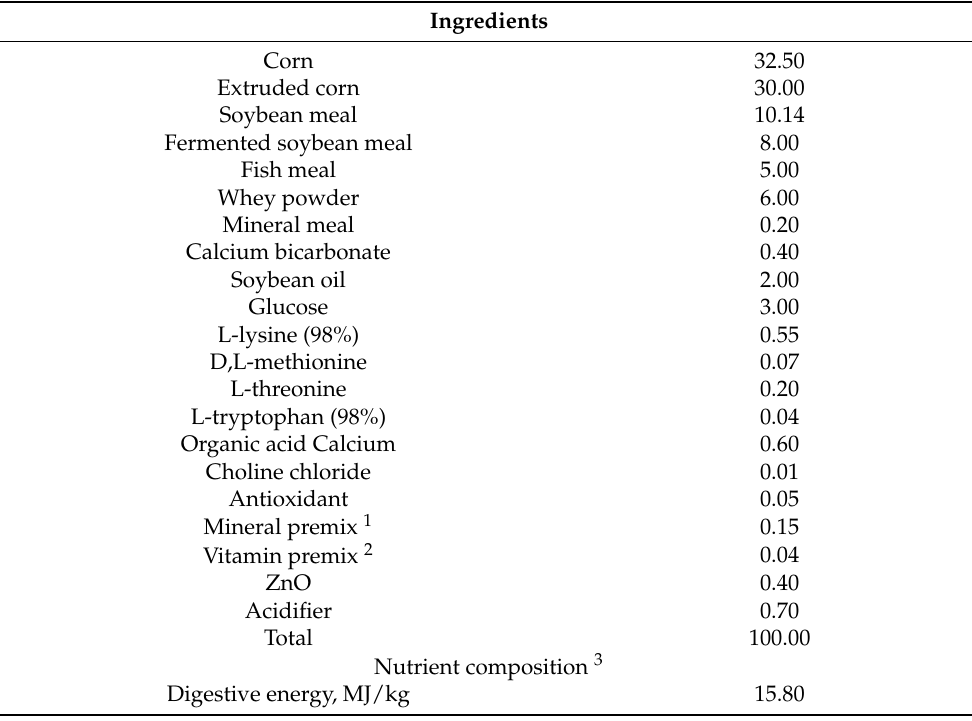
Figure 1. Ellagic acid supplementations alleviated the oxidative stress and growth-check of piglets challenged by paraquet. ( A ) Study design. ( B ) The BW changes of piglets on d-18 and d-21 of experiment (before and after PQ injection). ( C – E ) Superoxide dismutase (SOD), catalase (CAT) activities, and malondialdehyde (MDA) levels in serum of piglets. PQ = 4 mg/kg paraquet; EL = 0.005% ellagic acid + 4 mg/kg paraquet; EM = 0.01% ellagic acid + 4 mg/kg paraquet; EH = 0.02% ellagic acid + 4 mg/kg paraquet. n = 8. Data are shown as mean ± SEM. * in ( B ) means the difference was significant when compared to d-18. * in ( C – E ) means the difference was significant when compared to the control group. ns means the difference was not significant when compared to the control group. a – c Values with different lowercase letters are significantly different among PQ, EL, EM, and EH groups ( p < 0.05). Table 1. Ingredients and composition of the basal diet (%).